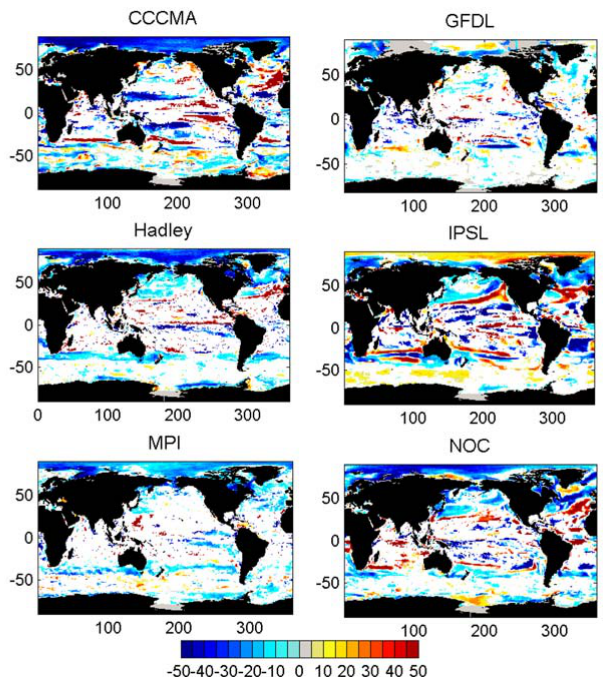
Fig. 4. Difference in timing of peak PP between the period 2006– 2026 and 2081–2100 (where negative values indicate earlier peak timing). Only points where a 1-way ANOVA analysis showed no significant difference in the means of the 2 periods (significance at 5% level) are plotted.